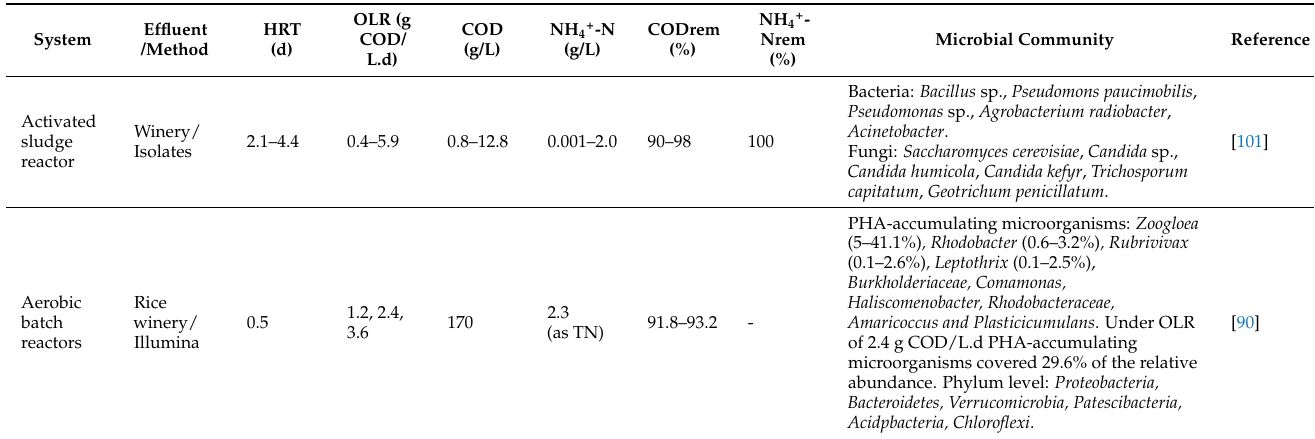
Table 2. Microbial communities in aerobic biosystems treating agro-industrial